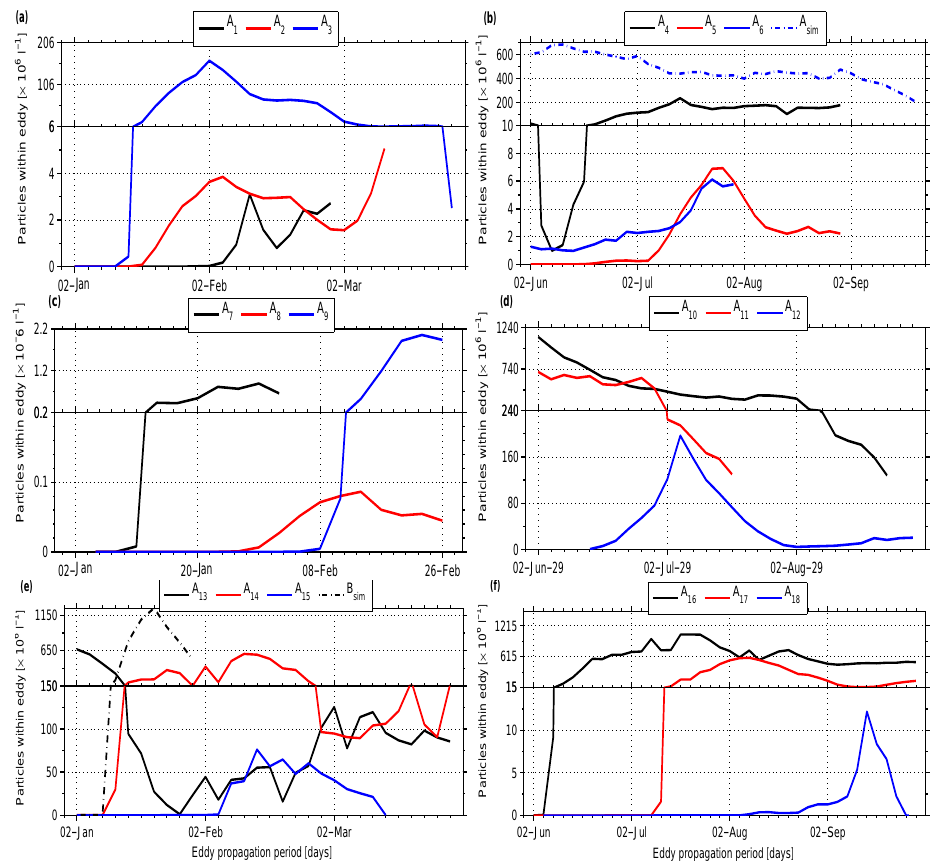
Figure 14. Particle distribution at the subsurface layer of anticyclonic eddies during their propagation, in summer (left) and winter (right) seasons. Anticyclonic eddies tracked at the vicinity of southern (a, b) , northern (c, d) and offshore (e, f) particle-release locations. Detailed description of particle-release experiments is in the Supplement. Note the change of the scale on the vertical